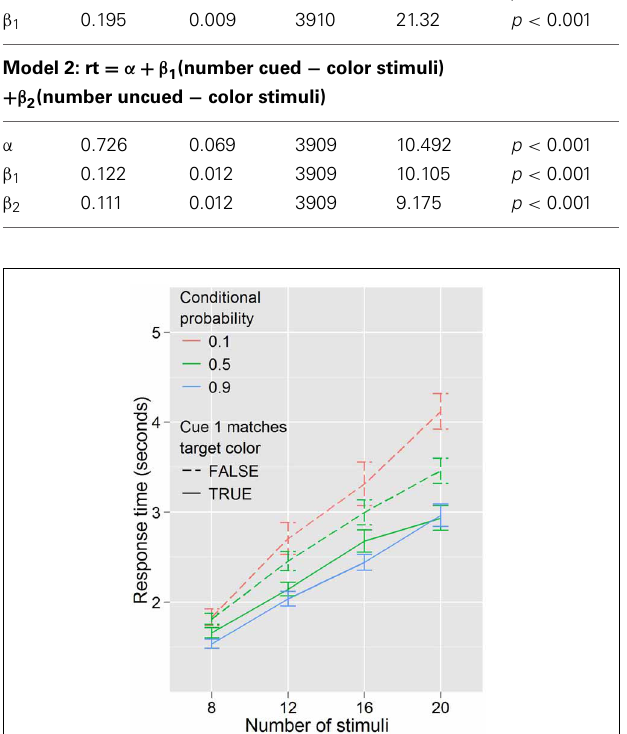
FIGURE 6 | Response times by distractor number for each of the three conditional probabilities in Experiment 3. Cue 1 never matched the target color when conditional probability was 0.1, always matched when conditional probability was 0.9, and matched half the time when conditional probability was